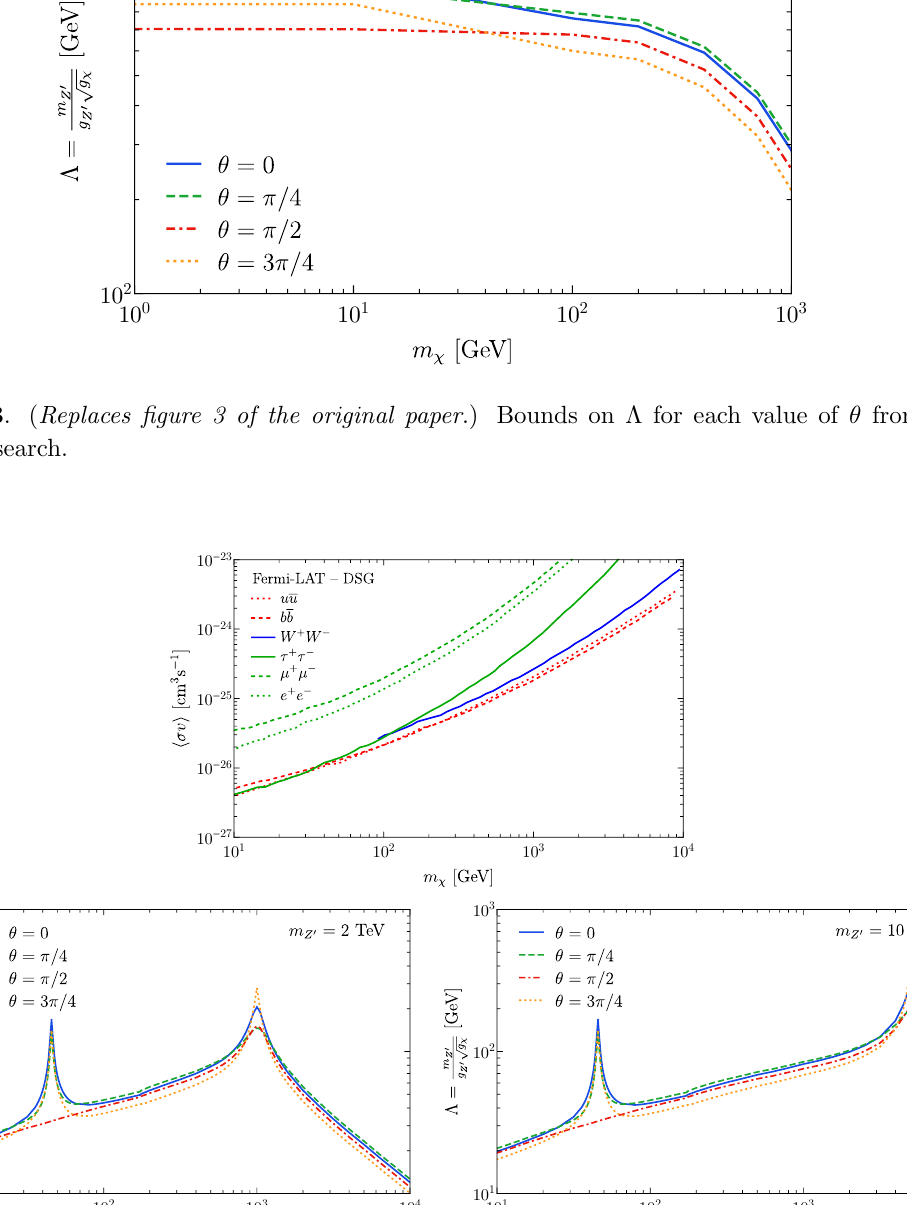
(cid:27)v from Fermi-LAT obser- h i (cid:27)v h i